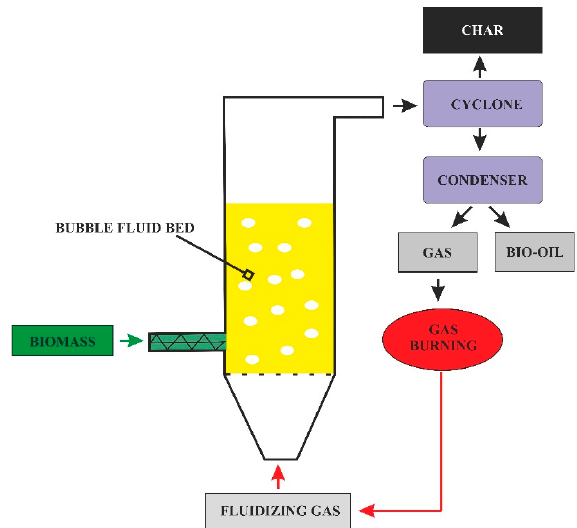
Figure 2. Bubble fluidized bed reactor.